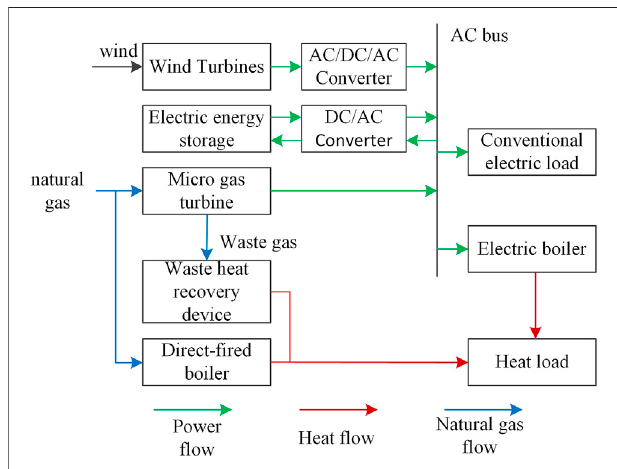
FIGURE1| Schematicdiagramofanisolatedcombinedheatandpower